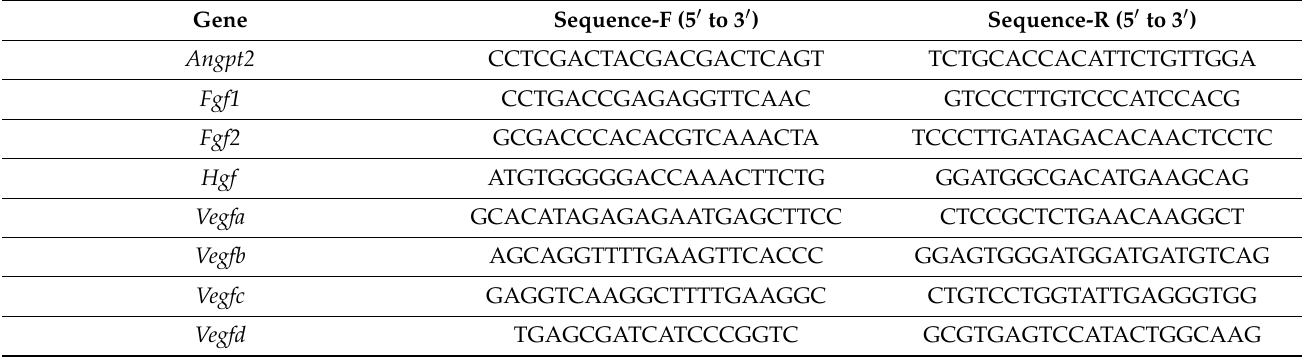
Table 1. Primer sequences used for